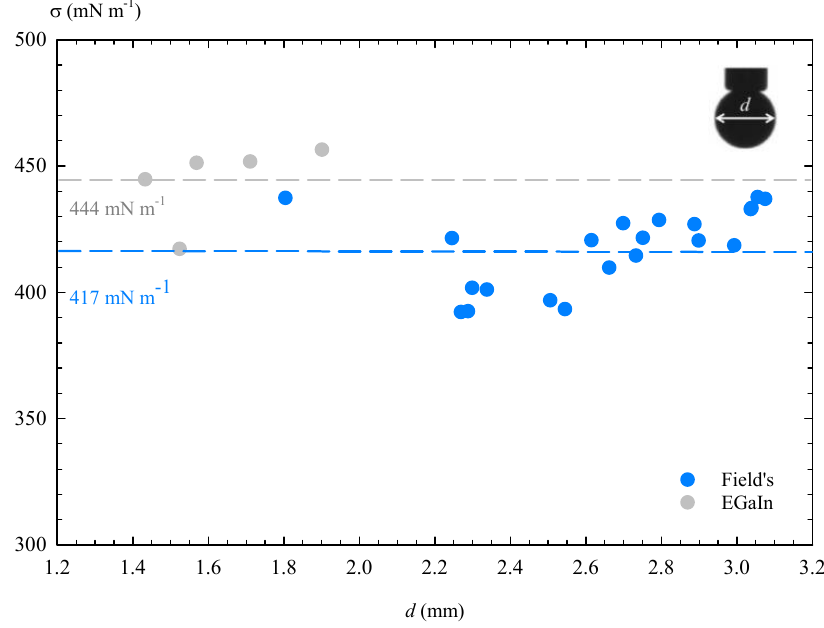
Figure 14. Surface tension ( σ ) of Field’s metal and EGaIn in inert N 2 atmosphere. In the presence of O 2 , the pendant drops of Field’s metal were measured over a wide range of sizes, revealing different surface tension value, as previously reported